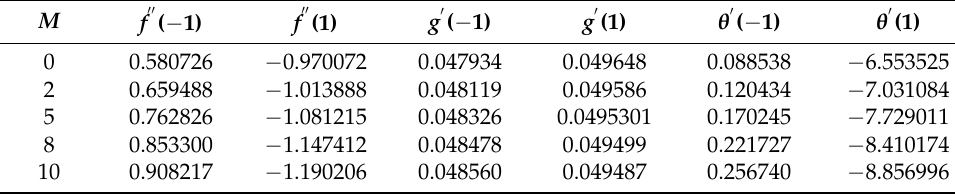
Table 5. Shear stresses, couple stresses, and heat transfer rate for different M .